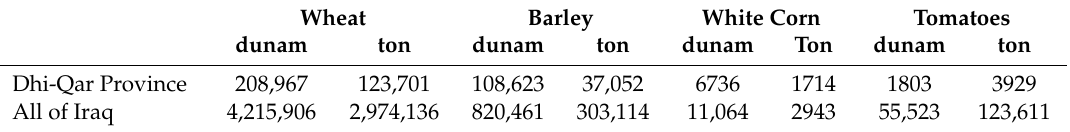
Table 11. The quantities produced and cultivated areas of the four crops covered by this study. Wheat Barley White Corn Tomatoes dunam ton